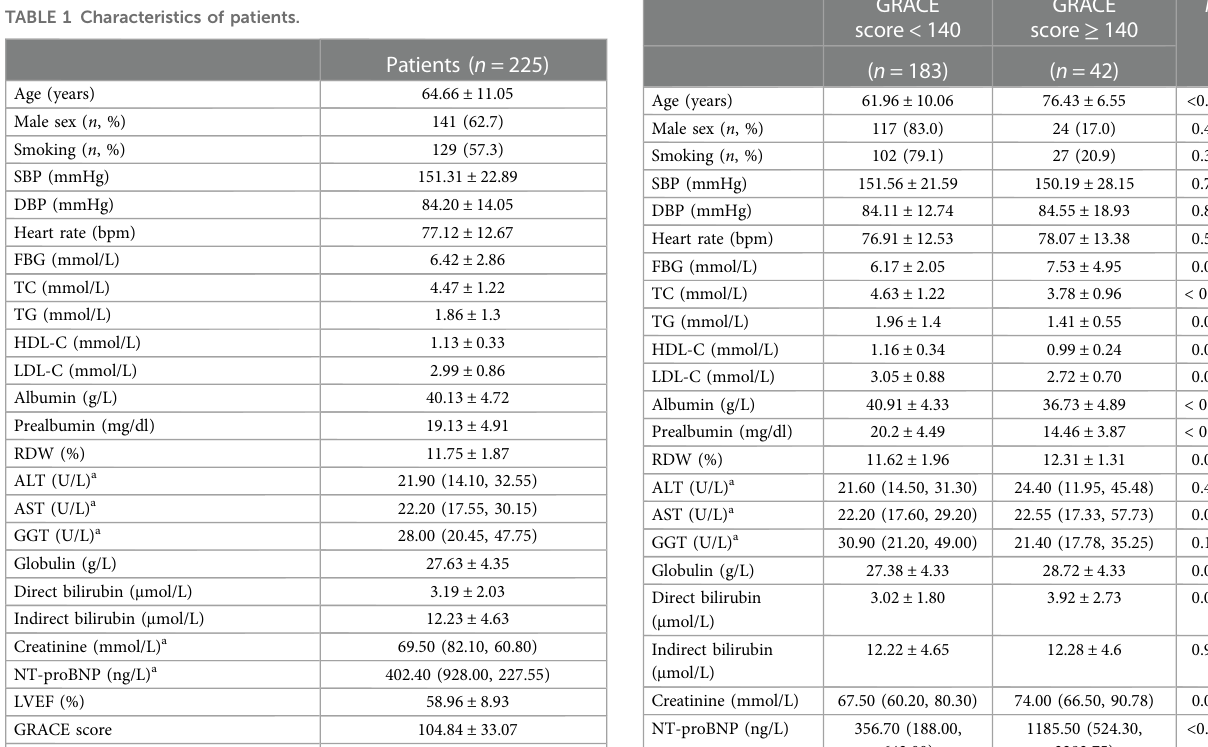
TABLE 2 Comparison of indexes in different GRACE score groups.